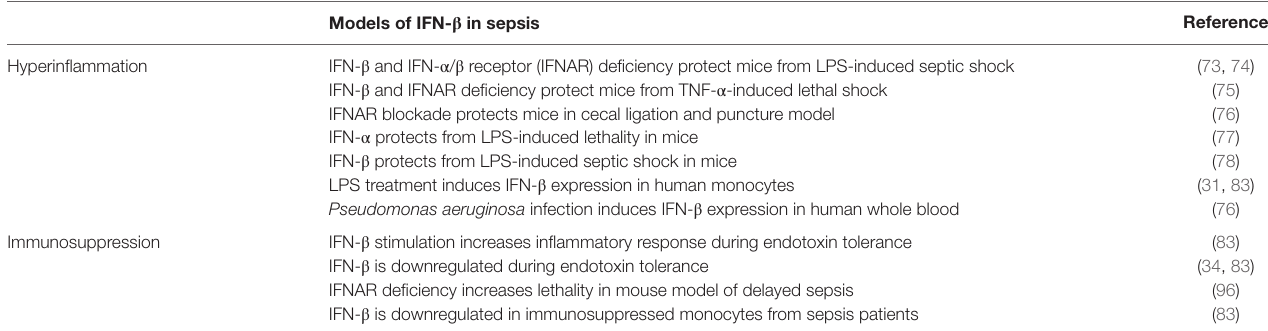
TABle 1 | Role of iFn- β in modulating hyperinflammatory and immunosuppressive responses in mouse models and humans. Models of iFn- β in